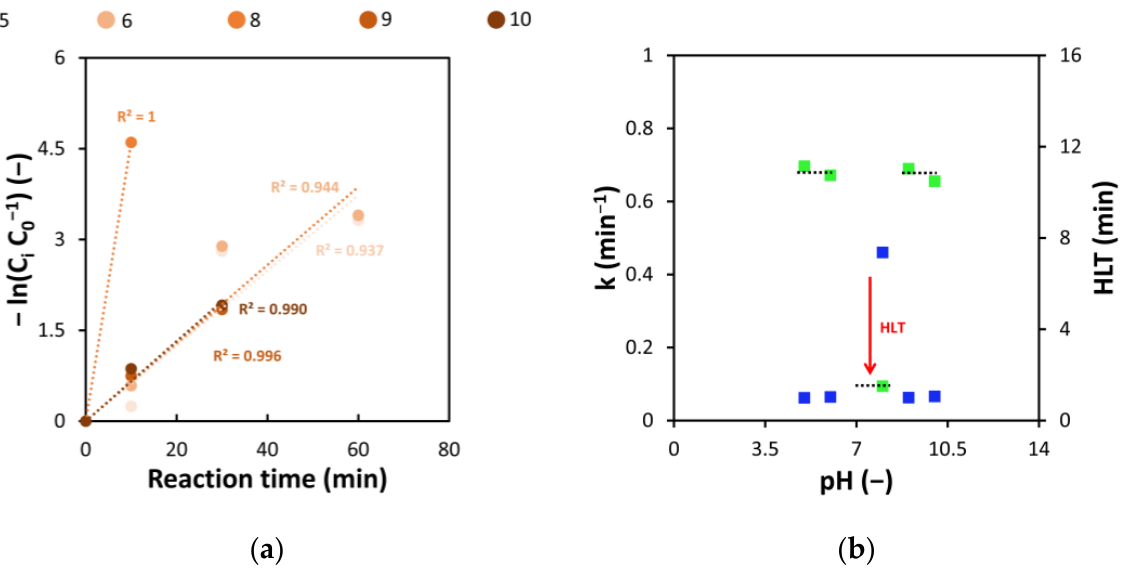
Figure 3. ( a ) Effect of initial pH on the electrochemical oxidation of arsenic. Initial As 3+ = 1000 µg L −1 ; conductivity= 780 µS cm −1 . ( b ) Pseudo first-order kinetic constants k ( blue ) and HLT ( green ) as a function of initial pH.